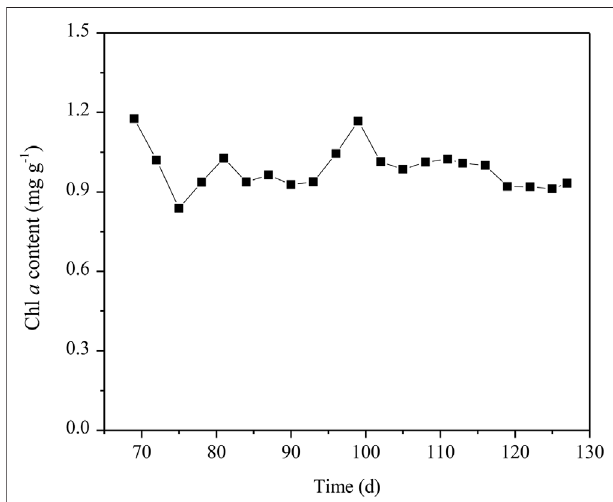
FIGURE 7 | Chl a content in the algae-intensi fi ed PN and algammox reactors.